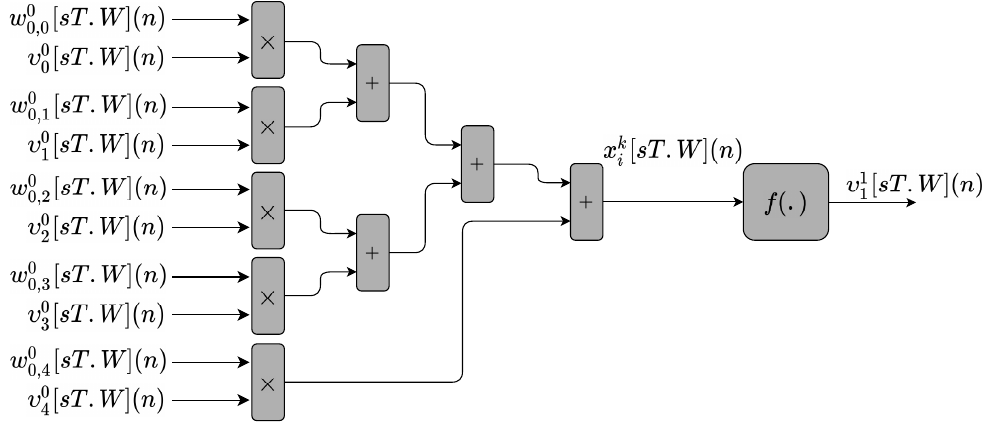
Figure 12. Block diagram representing the circuits used to implement the neurons of the MLPM module for both the MLP-BP and RMLP-BP.